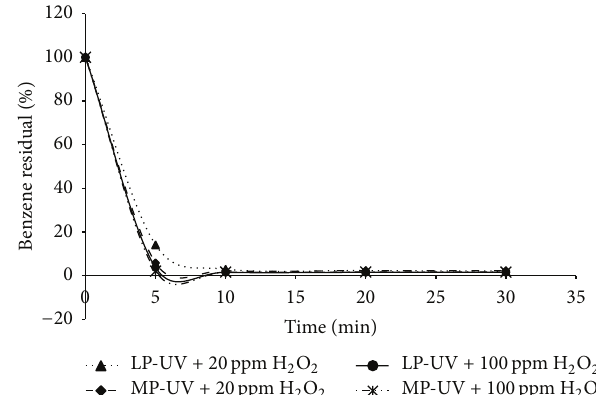
Figure 5: Removal of benzene using UV/H 2 O 2